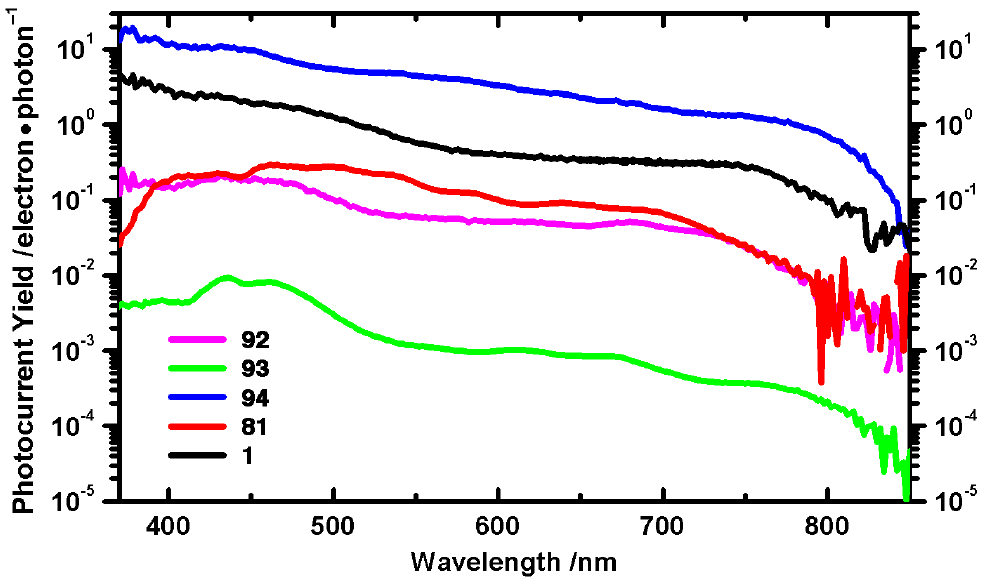
Figure 10. Photocurrent yield (370–850 nm) for dimers 92 – 94 and related monomers 1 and 81 . Figure adapted with permission from reference [80]. Copyright 2008 American Chemical